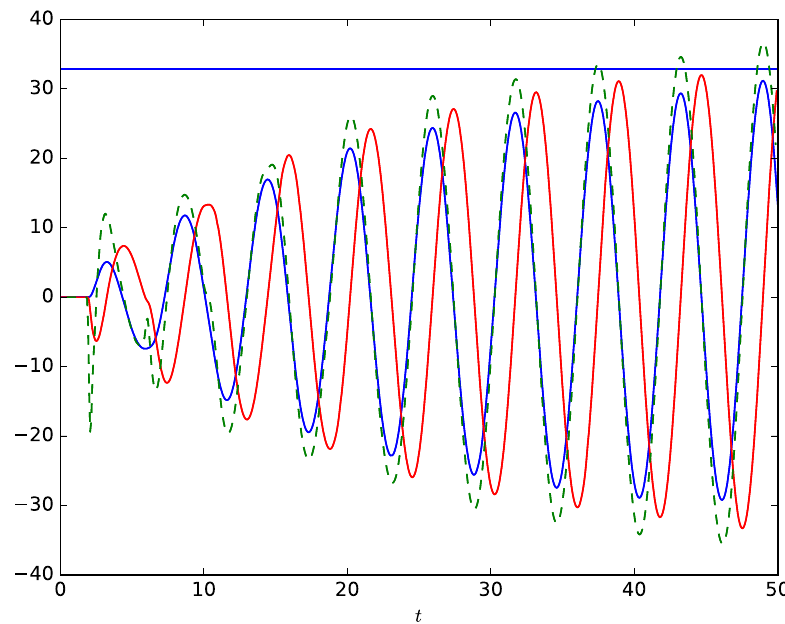
Figure 7. The blue continuous curve is the run-up (calculated using Eq. 47) normalized by the incident wave amplitude as a function of time. The channel width, 2 a , is equal to 0.2. The incident wave is given as η I sin ( (cid:60) ω 1 (t + (x − 1 )))θ(t + (x − 1 )) , where ω 1 is the lowest 0 free mode frequency for Model-2 (see Table 2 for D = 0), smoothed by multiplying it with the tanh function as in Fig. 5. The continuous red curve is the shoreline velocity. The dashed green curve is the shoreline acceleration. The horizontal blue line is the maximum run-up calculated using conformal mapping.